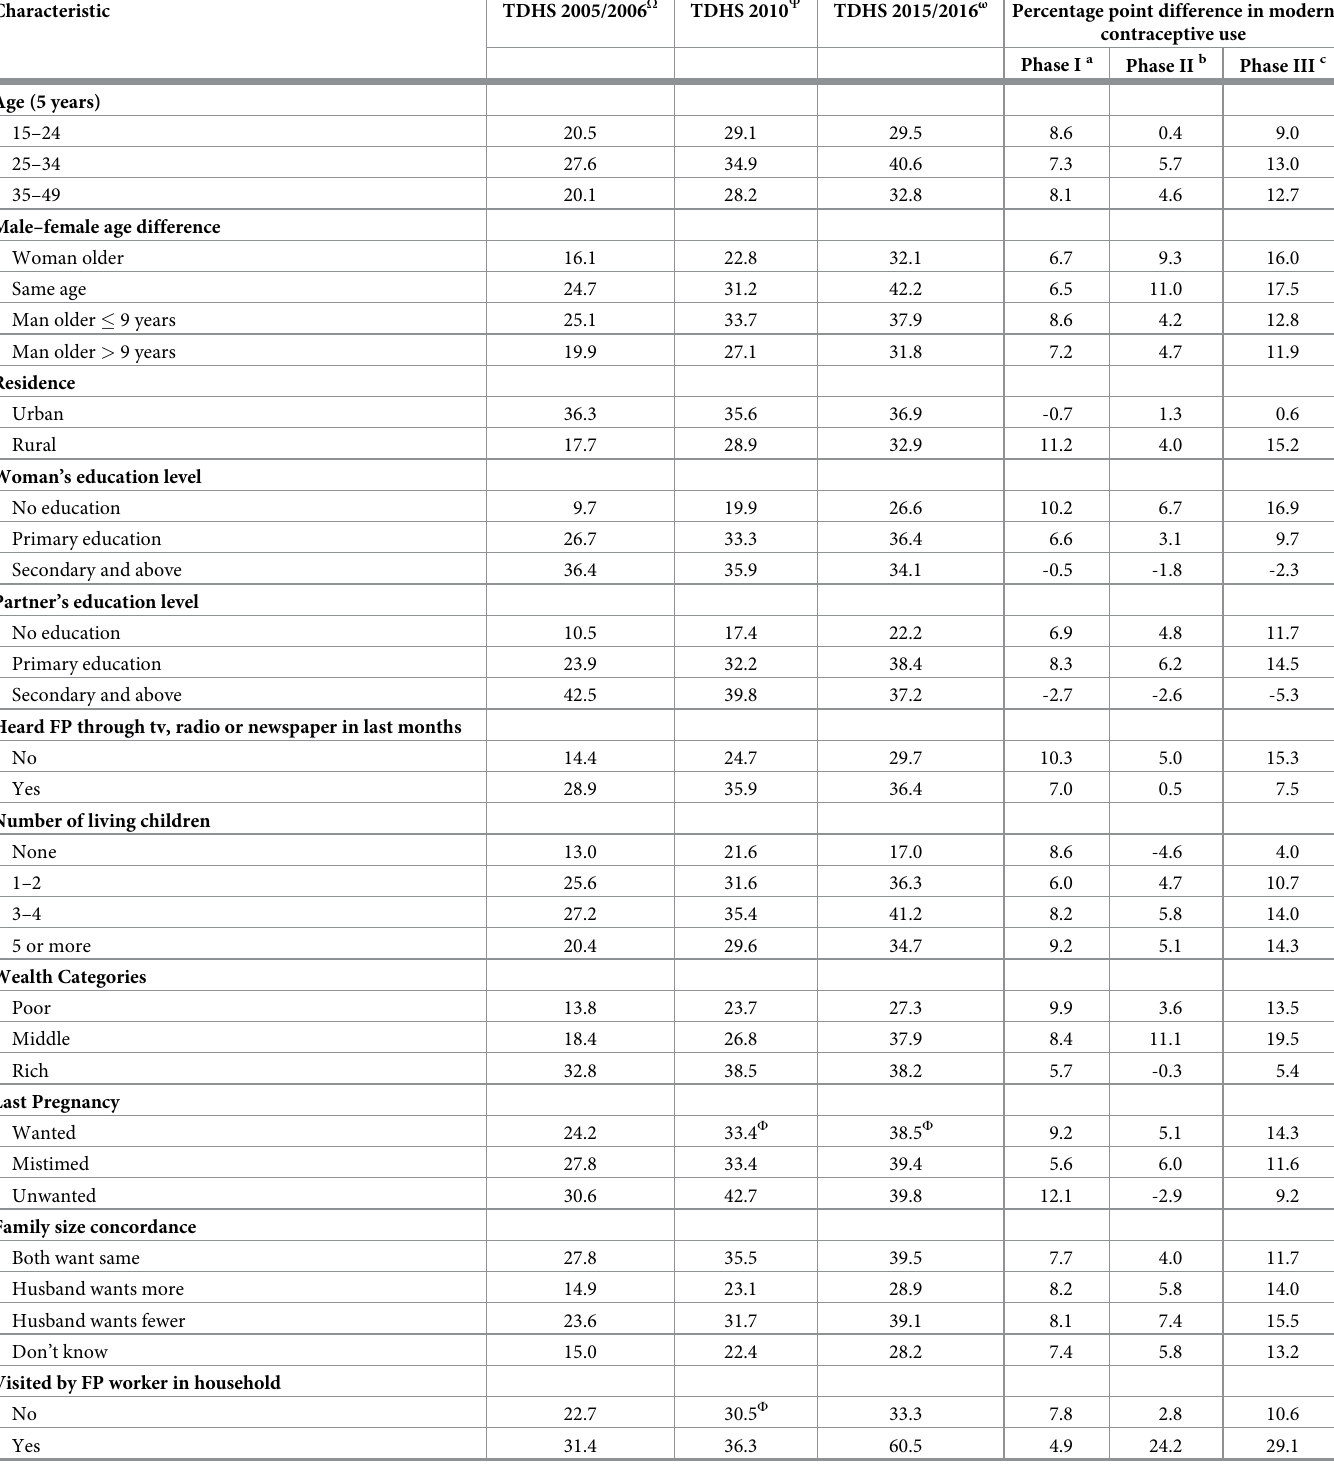
Table 2. Trends in modern contraceptive use among women aged 15–49 years by selected characteristics, in the TDHS 2004/2005, 2010 and 2015/2016 surveys (N = 26,141).